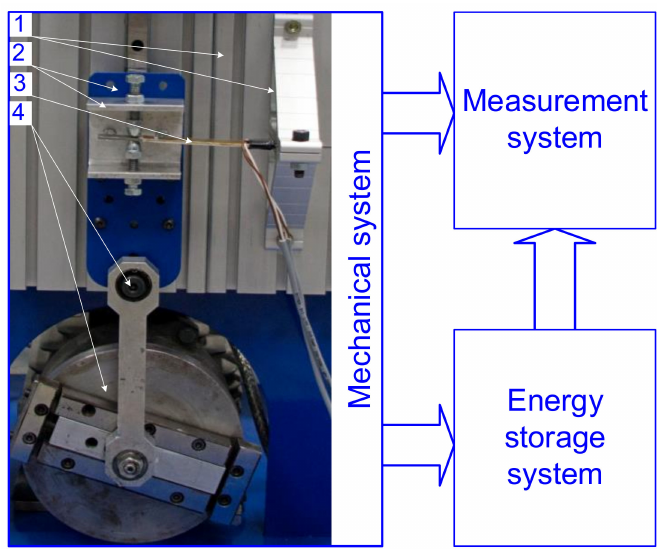
Figure 2. Main parts of laboratory stand.